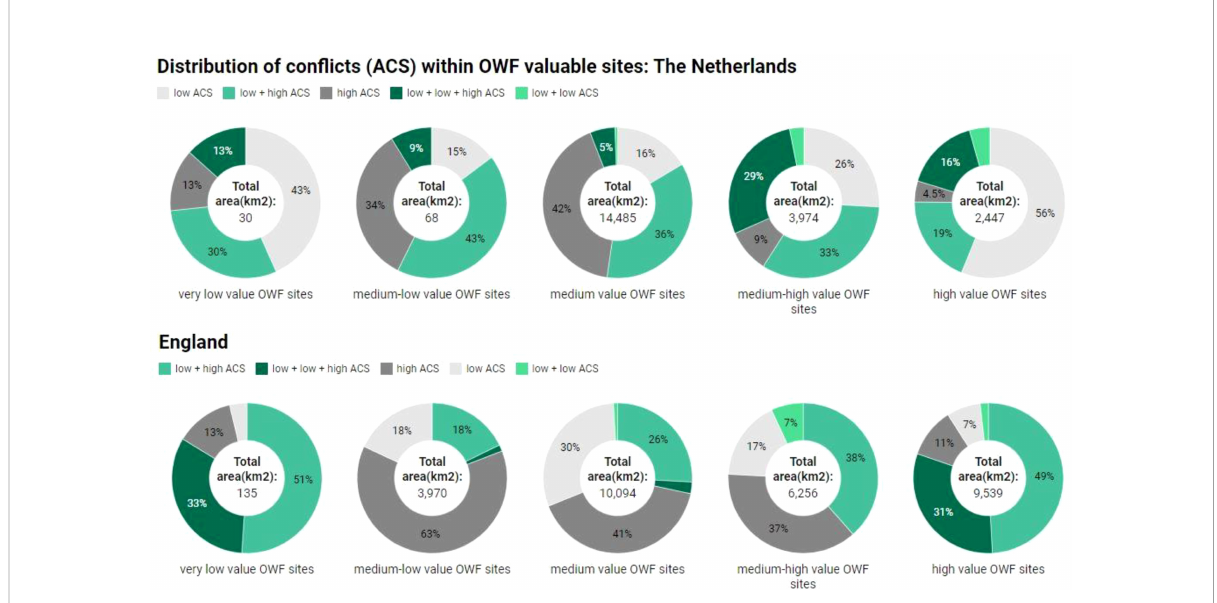
FIGURE 12 Spatial distribution (cumulated area of con fl ict) of con fl icts (ACS) within the OWF valuable sites, for shipping activities sea user group